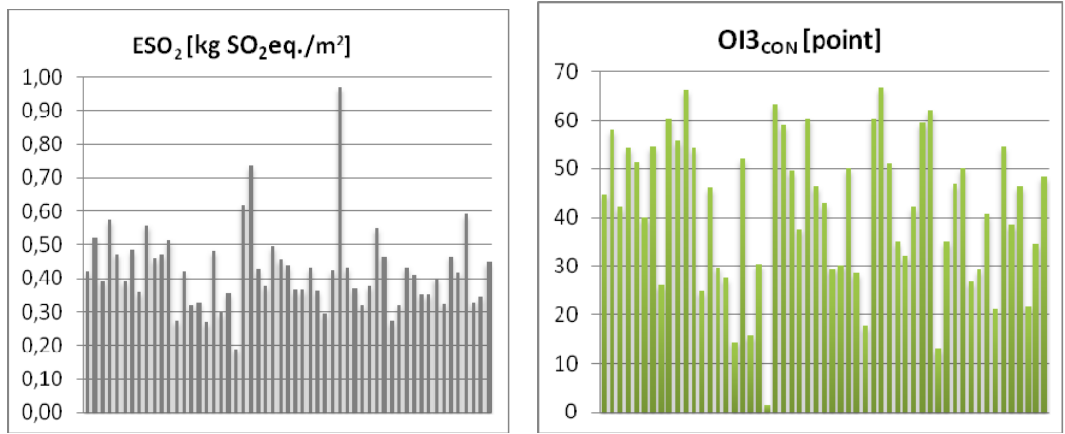
Figure 13. Environmental indicators of material compositions of roof structures.